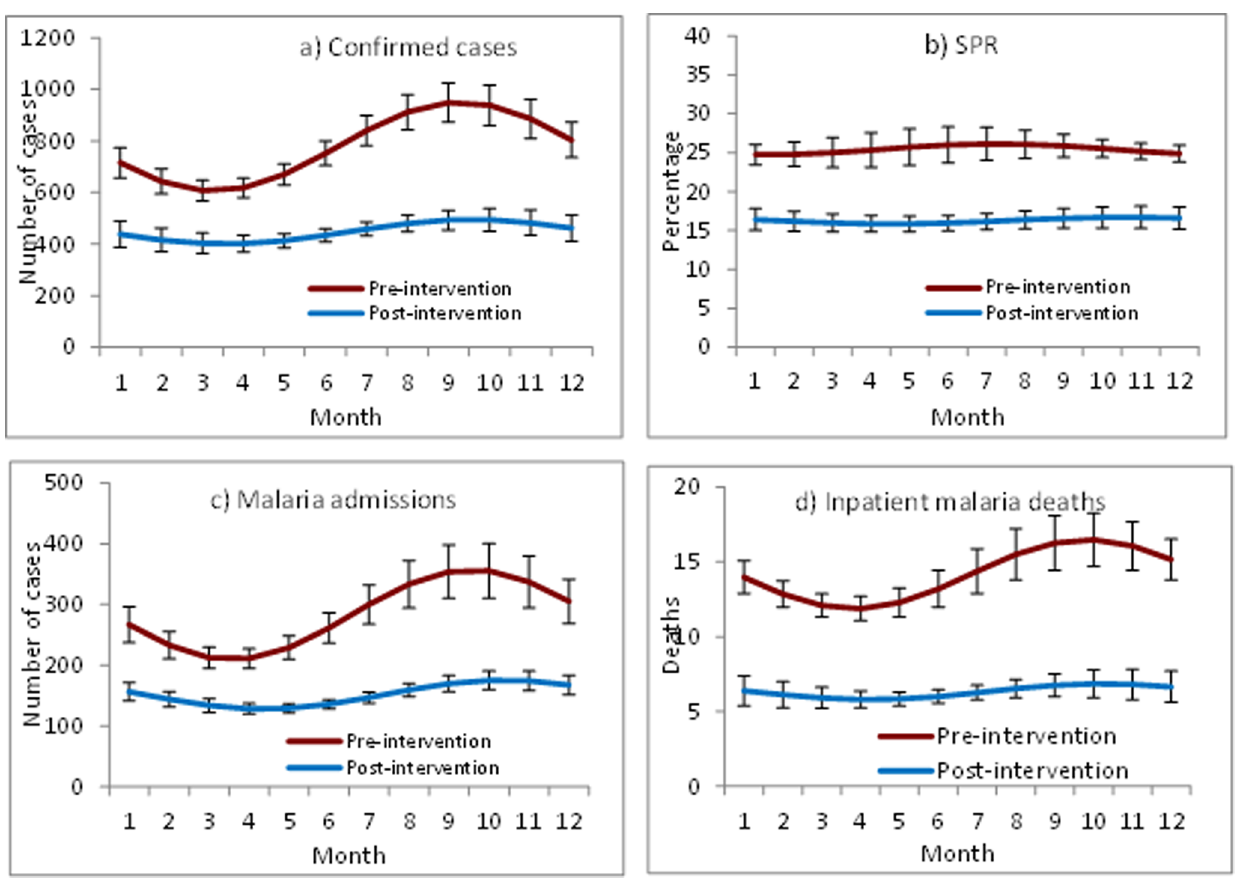
Figure 6. Monthly mean number of malaria confirmed cases, malaria inpatient cases, malaria deaths and slide positivity rate, 2001– 2005 and 2006–2011, 41 hospitals, Ethiopia.